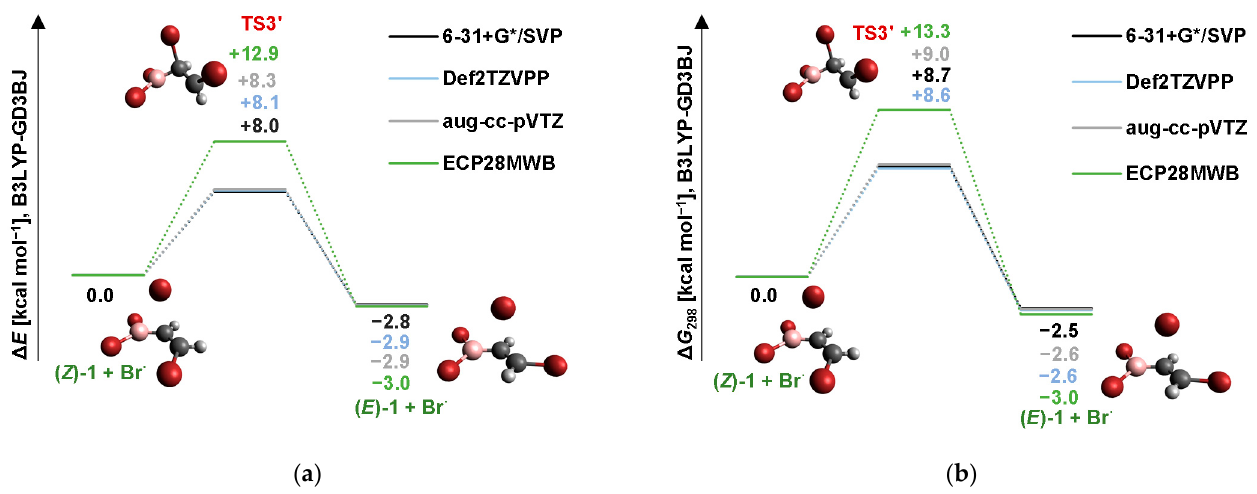
Figure 8. B3LYP-GD3BJ (ECP28MWB only for bromine atoms) Gibbs free energy profile for bromine radical addition to the “boron end” of ( Z )-1 followed by clockwise rotation around the C–C bond. For a key to atom color scheme, cf. caption of Figure 1.